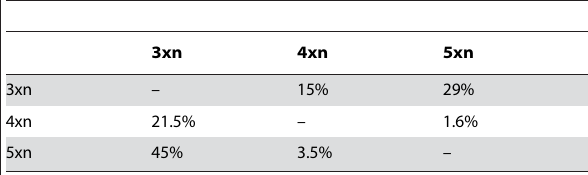
Table 1. Median Difference in Frequency of Motif Sets Searched across Different Classes of Bistable Systems.